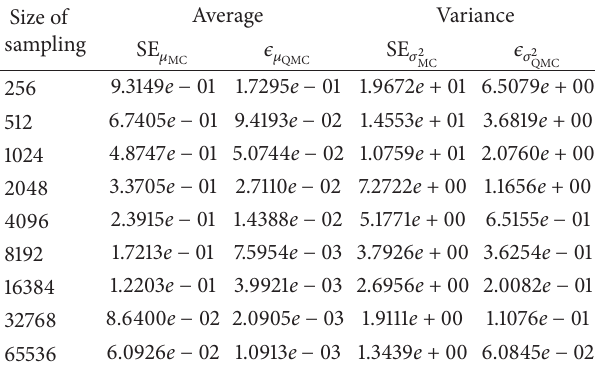
Table14:ErrorsofaverageandvariancecomputedbyMCandQMC